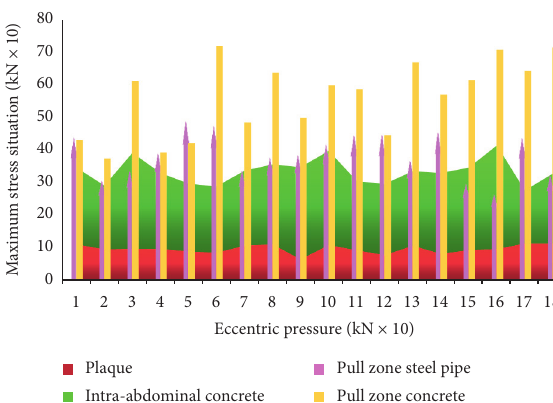
Figure 9: Maximum stress of adjacent steel tube and concrete